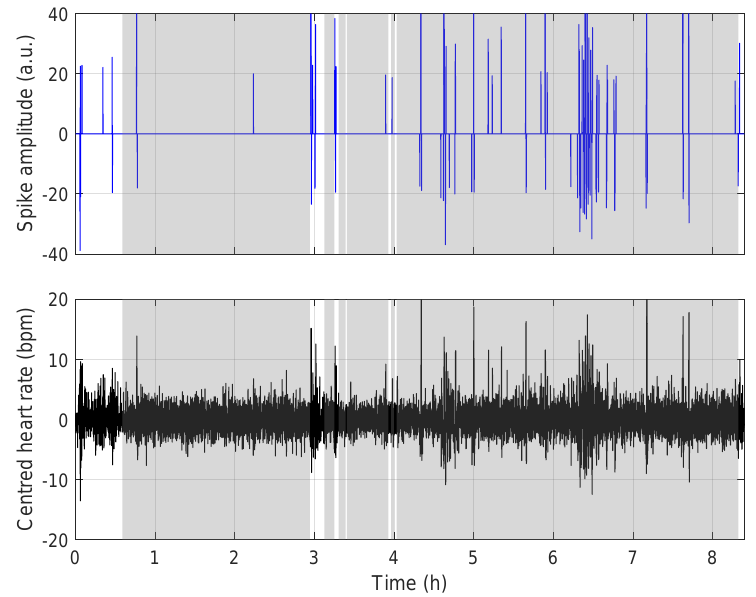
Figure 13. PhysioNet: recording “A-18”, an example where our model underestimates AHI. The same representation as in Figure 9; there is no visible bradycardia–tachycardia event associated with apnoea (which constitutes most of the recording, according to the ground truth).